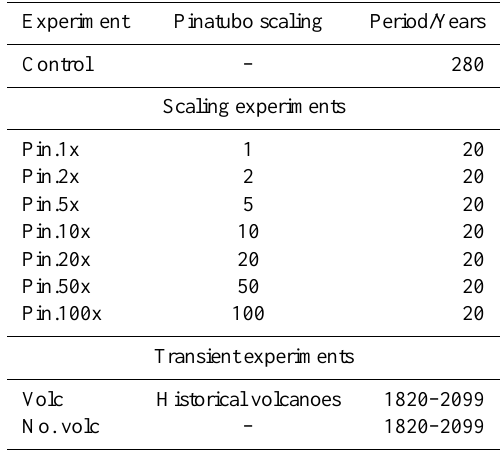
Table 1. Overview of all experiments, the magnitude of Pinatubo scaling, and the lengths of the simulations. All experiments are started from nearly steady state preindustrial conditions using the same initial